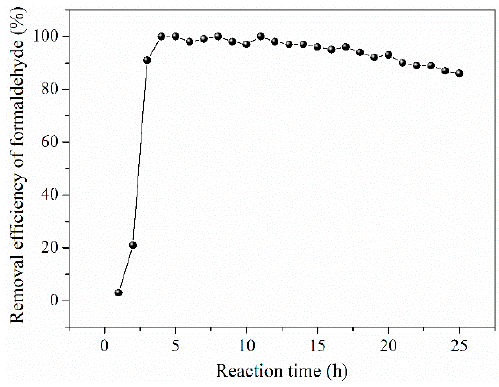
Figure 10. Stability of the representative catalyst 0.01BiOCl/MnMgAlO .